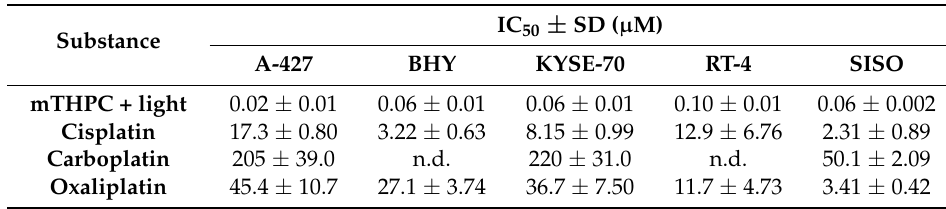
Table 1. Calculated IC 50 values from MTT viability assay for mTHPC + light and the Pt(II)